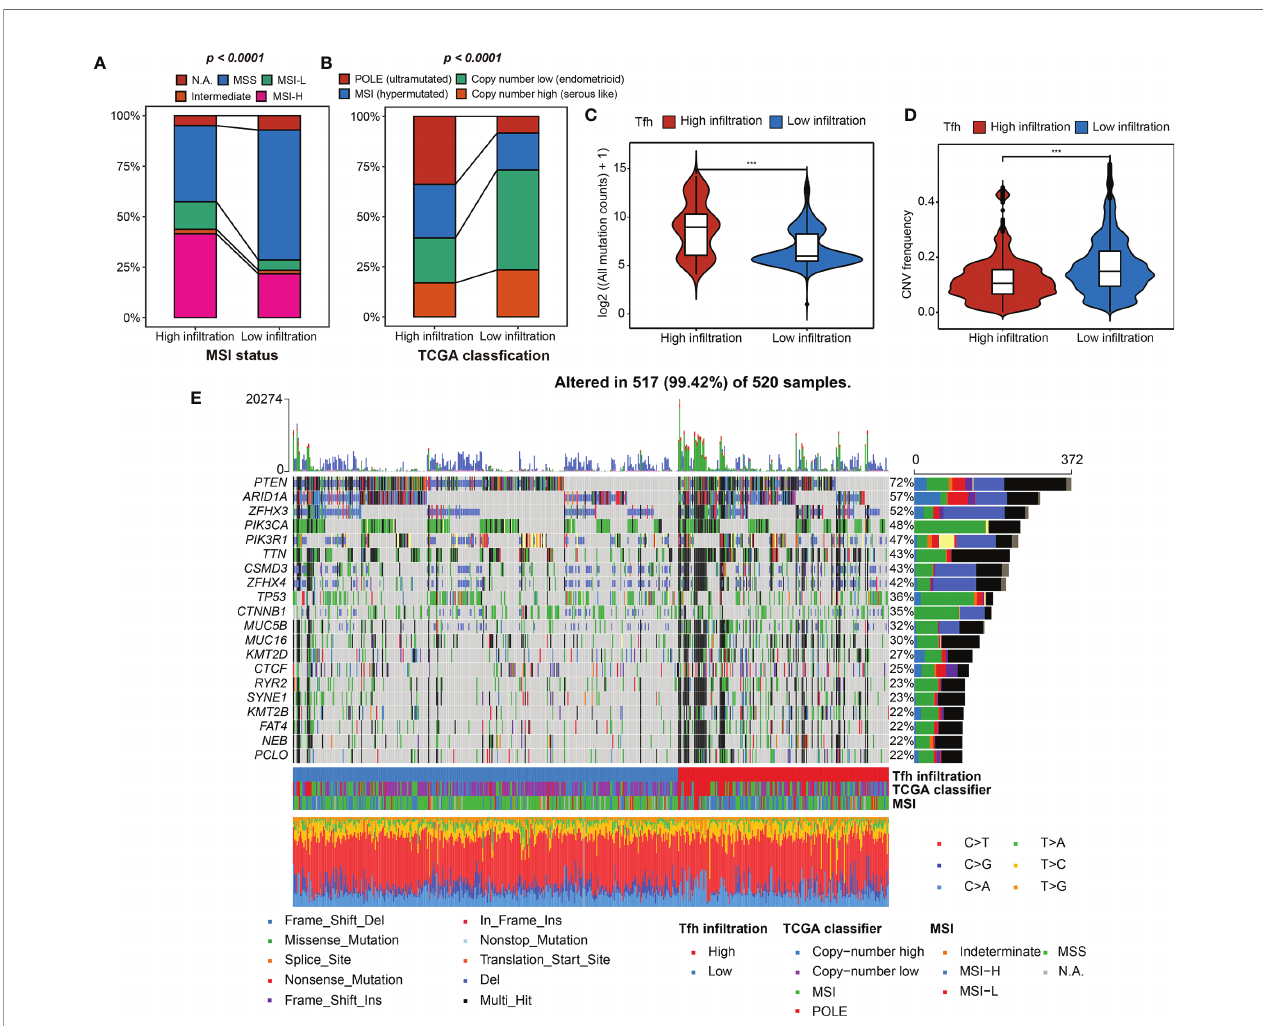
FIGURE 3 | Tfh in fi ltration subtypes and related genomic features. (A, B) The fraction of MSI status, TCGA classi fi cation, shown in high- and low-Tfh in fi ltration groups. (C, D) Distribution of the mutation counts (log2 scale) (C) and CNV frequency (D) in high- and low-Tfh in fi ltration groups. Middle line: median; box edges: 25th and 75th percentiles, whiskers: most extreme points. *** p < 0.001, Wilcoxon rank-sum test. (E) The genomic pro fi les of 520 EC patients. Top: mutation counts of the mutated genes in each patient. Bottom: The 520 patients and immune and genomic subtypes. Right: Gene variant types and their frequencies are shown by a bar